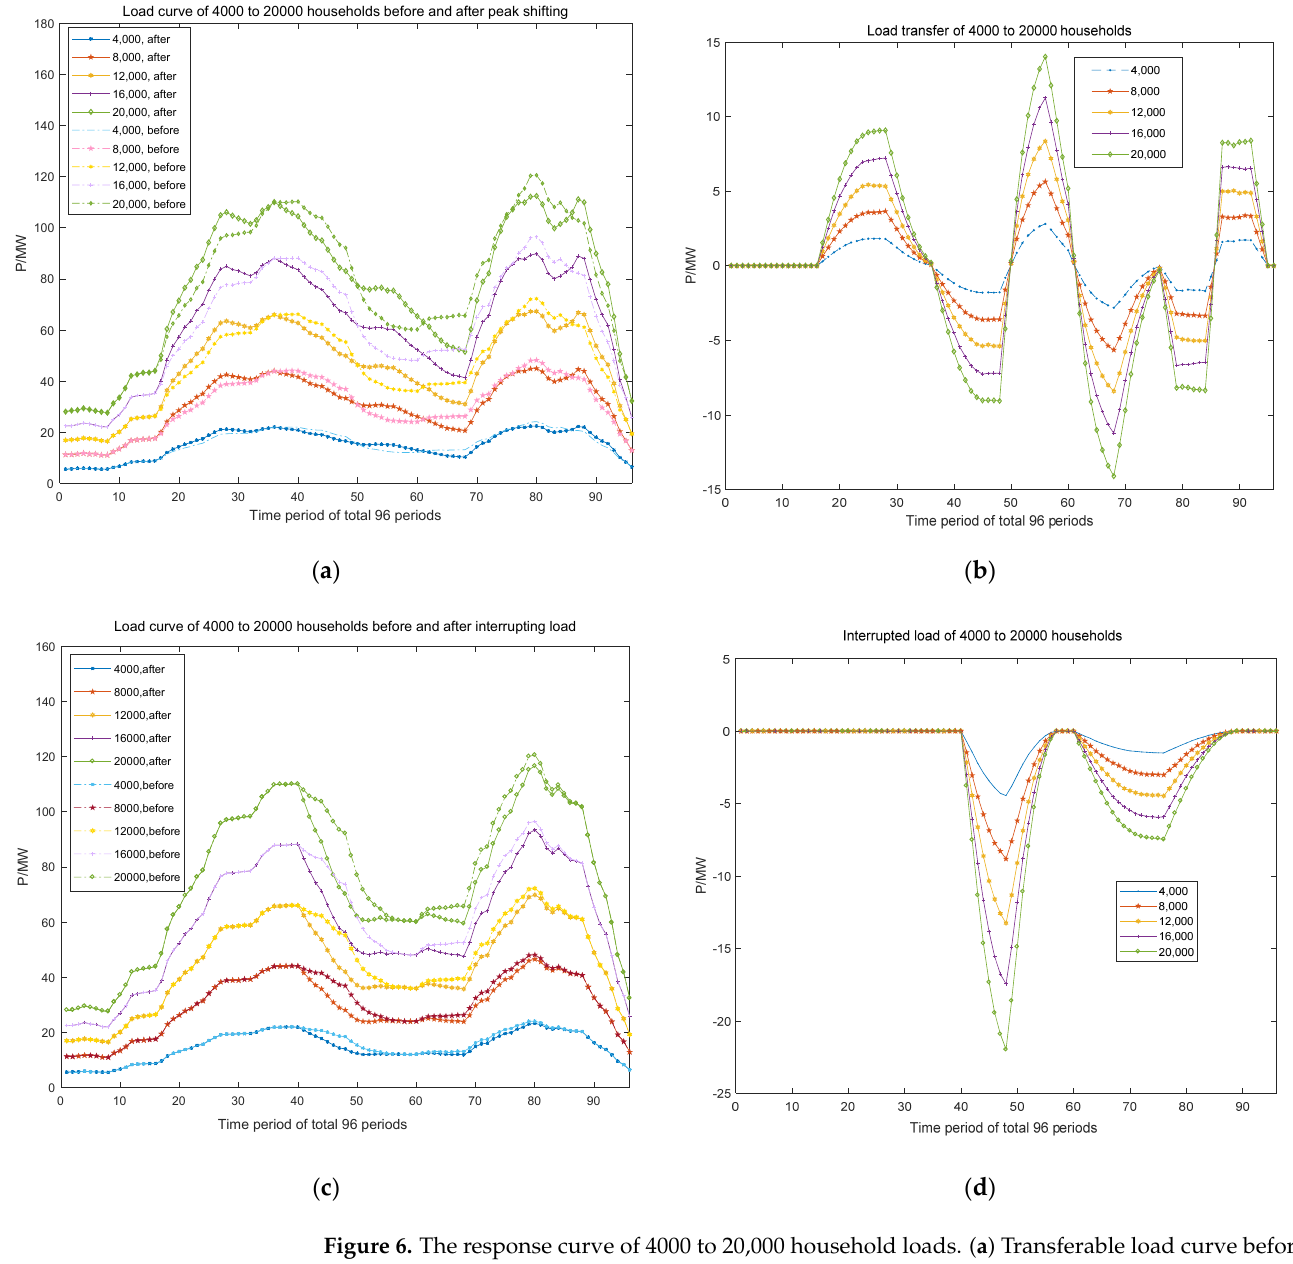
Figure 6. The response curve of 4000 to 20,000 household loads. ( a ) Transferable load curve before and after peak shifting and valley filling; ( b ) load transfer curve; ( c ) interrupted load curve before and after interrupting load; ( d ) interrupted load curve.